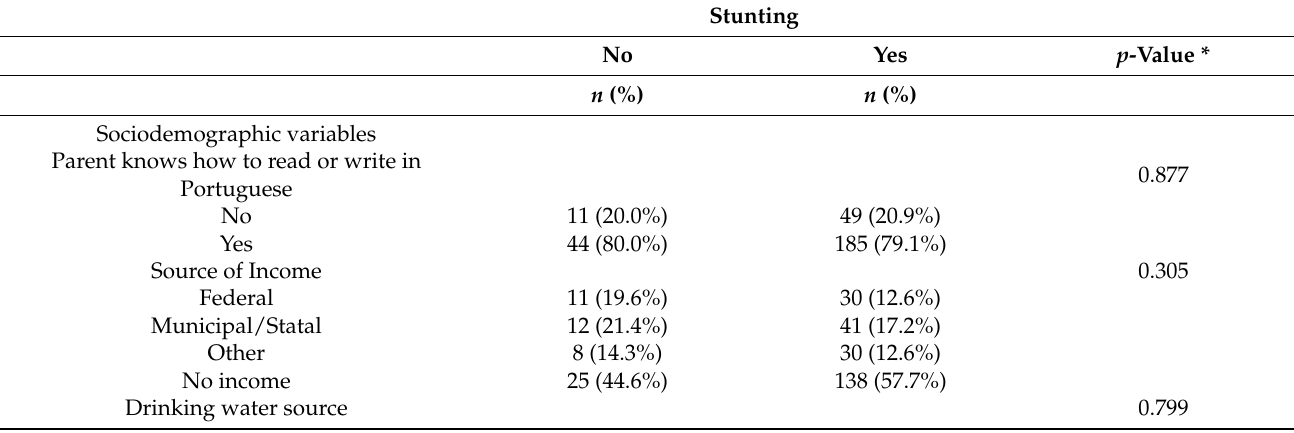
Table 3. Proportion of children under five years of age with and without stunting according to sociodemographic, maternal and child variables. Yanomami Indigenous Territory, Brazilian Amazon,